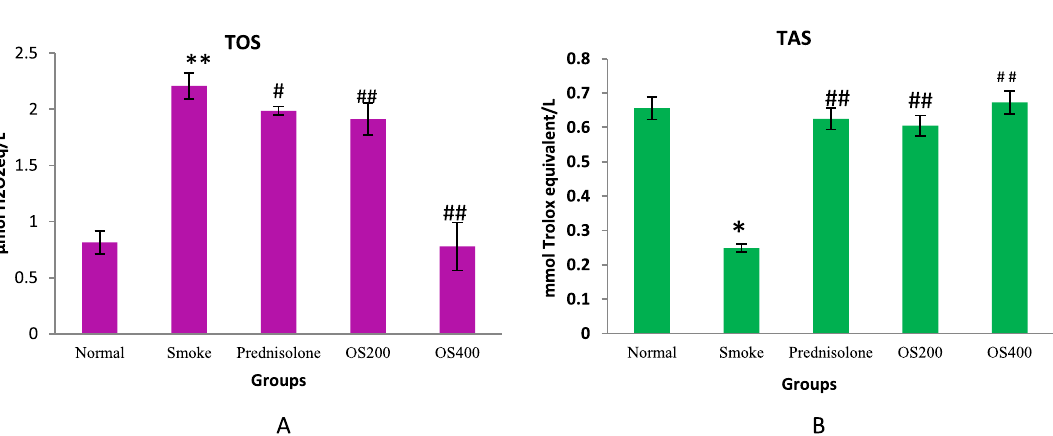
Figure 1. OLE inhibited the recruitment of immune cells to lungs as represented by Total cell count ( A ), Differential cell count ( B ), Cytospin slides ( C ): CS exposure leads increased leukocytes recruitment along with neutrophils and macrophages in lungs which were inhibited by the administration of OLE 200 mg/kg and 400 mg/kg doses. Values are expressed as mean ± SEM. Results were analysed statistically by one way ANNOVA followed by Turkey’s test. **p < 0.05 versus the normal group; # p < 0.01 and ## p < 0.05 versus the COPD group. Red arrow represents macrophages; Black arrow represents neutrophils.